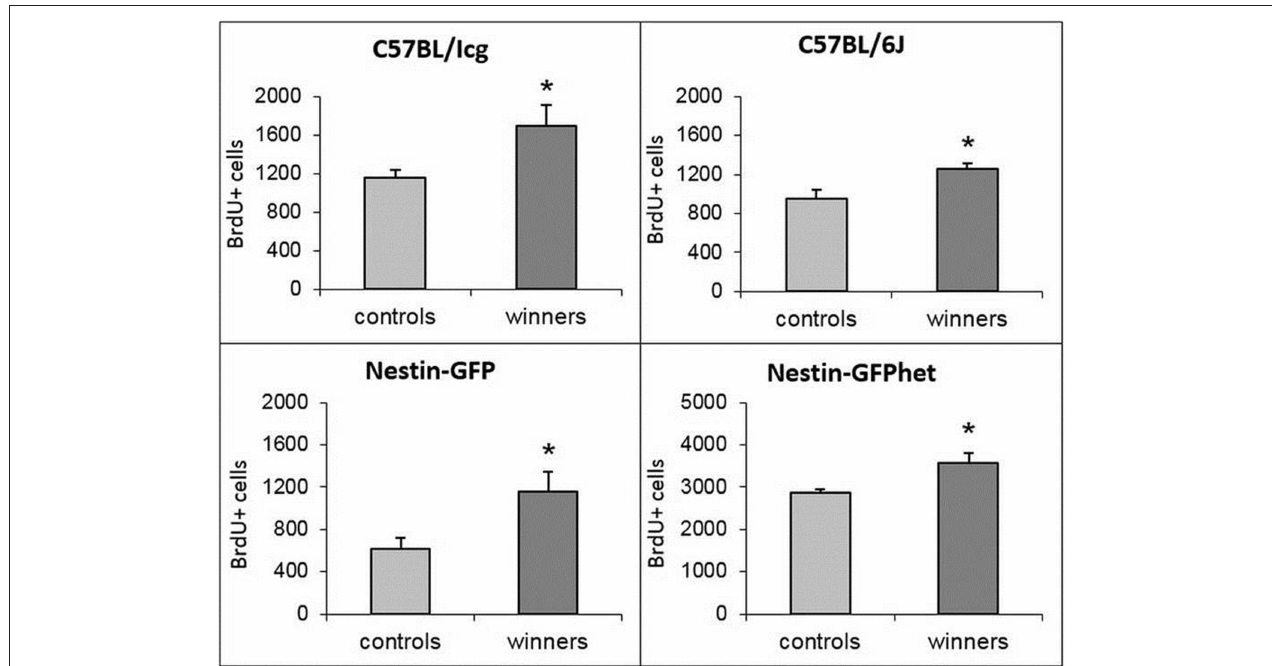
FIGURE 2 | BrdU-positive cells in the SGZ of the DG of control and winning males of four lines (captions). * P < 0.05 , t